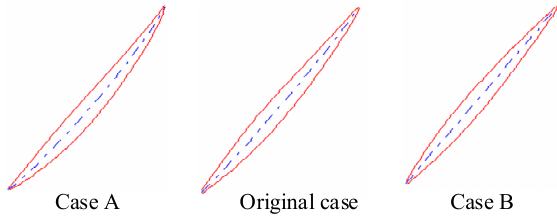
Figure 3. The airfoil of three camber cases.